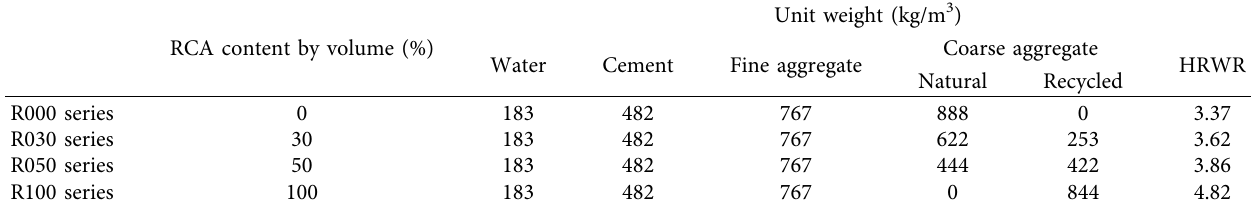
Table 2: Mix proportions for the test beams.